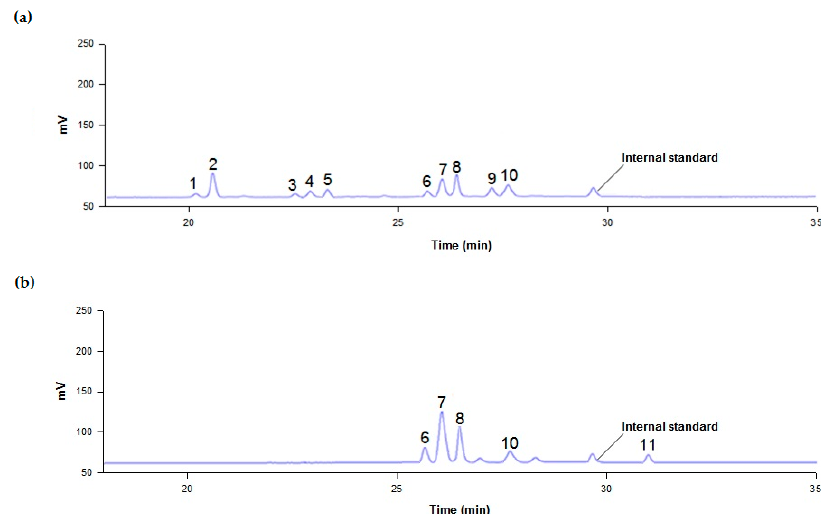
Figure 5. HPLC peaks of ( a ) platycosides in the Platycodi radix extract, and of ( b ) deglucosylated platycosides obtained through biotransformation by C. bescii β -glucosidase after 2.3 h. (1) Deapiosylated (deapi)-platycoside E, (2) platycoside E, (3) deapi-platycodin D3, (4) platycodin D3, (5) polygalacin D3, (6) deapi-platycodin D, (7) platycodin D, (8) polygalacin D, (9) 3 ″ - O -acetyl polygalacin D3, (10) platycodin A, and (11) 3 ″ - O -acetyl polygalacin D.